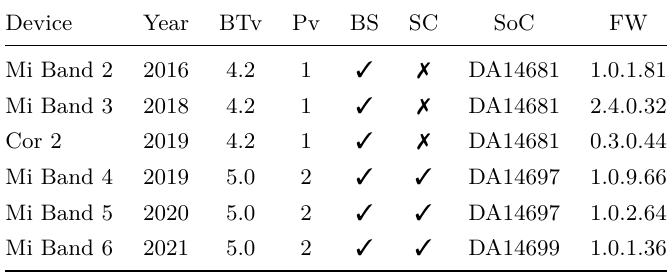
Table 3: Fitness trackers’ technical specifications. The columns contain the device name, release year, supported Bluetooth version (BTv), Pairing protocol version (Pv), BLE link- layer security support (BS), BLE Secure Connections (SC) support, used system-on-chip (SoC), and Mi Fit firmware version